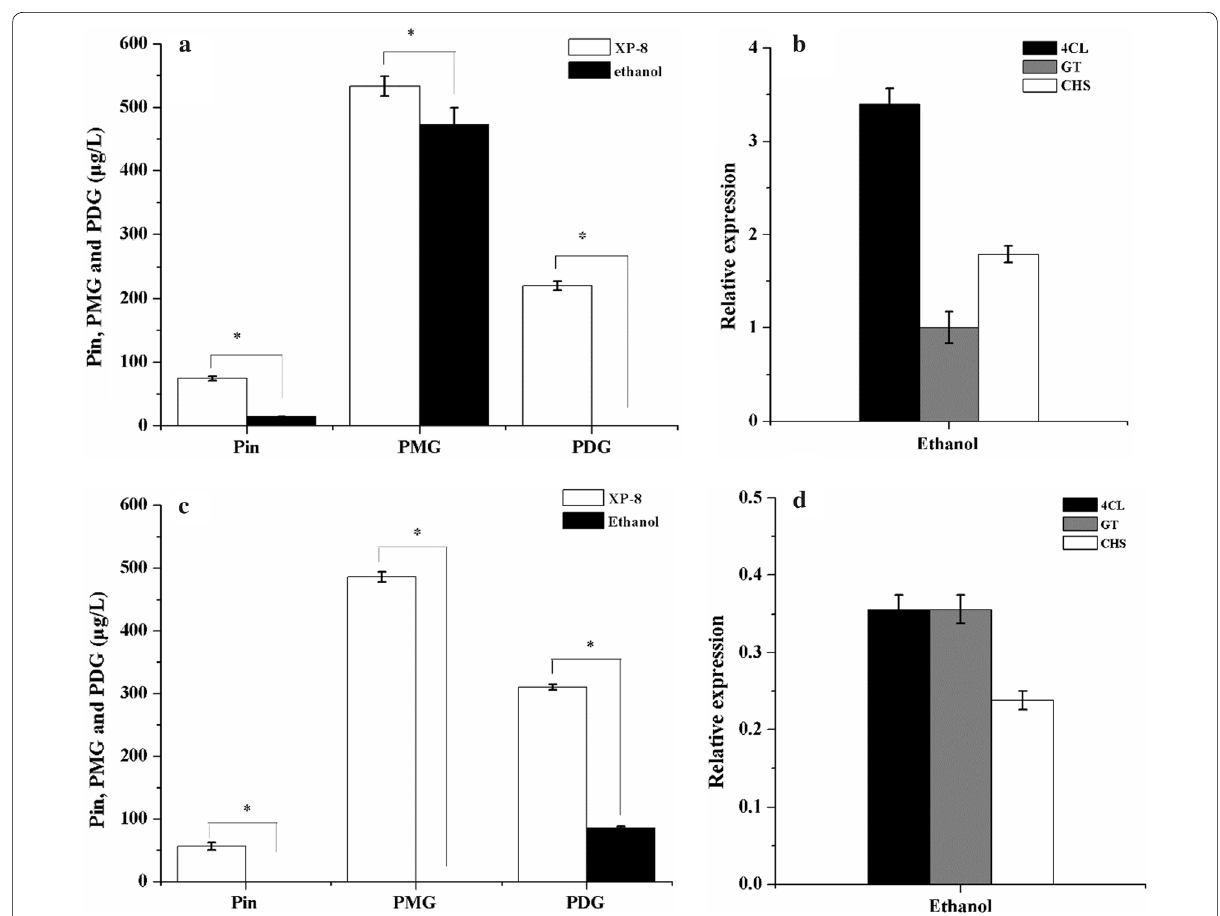
Fig. 6 Output levels of target products and expression levels of the genes obtained using ethanol induction in the systems containing the PDB medium ( a , b ) and resting cells ( c , d